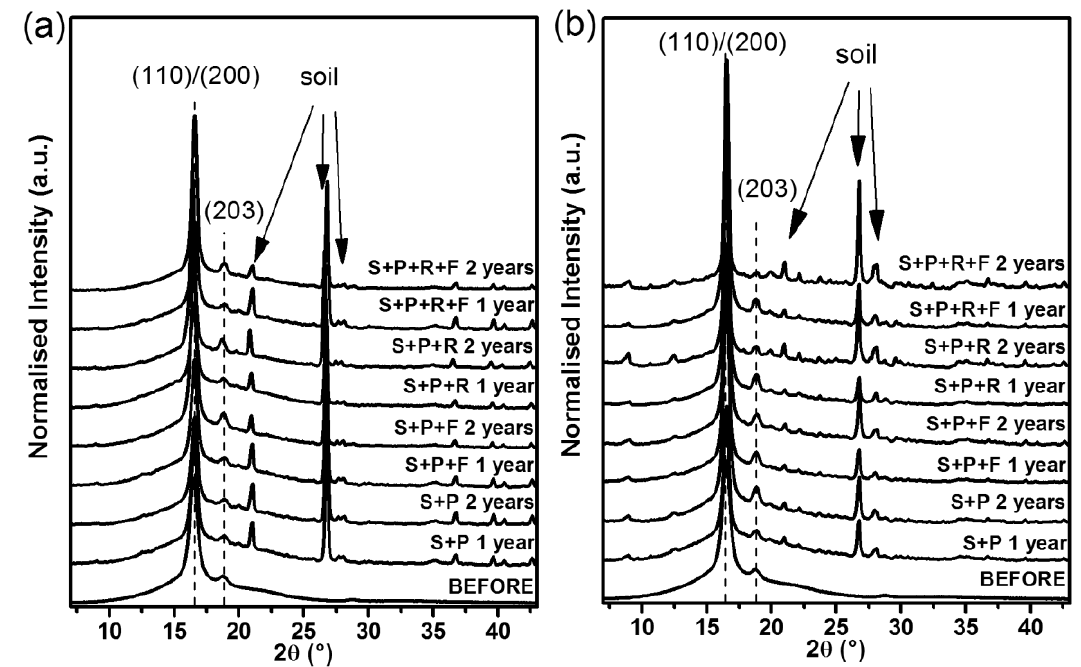
Figure 5. WAXS diffractograms of PLA spun-bonded mulching nonwovens before and after composting in ( a ) Cracow and ( b ) Plovdiv.